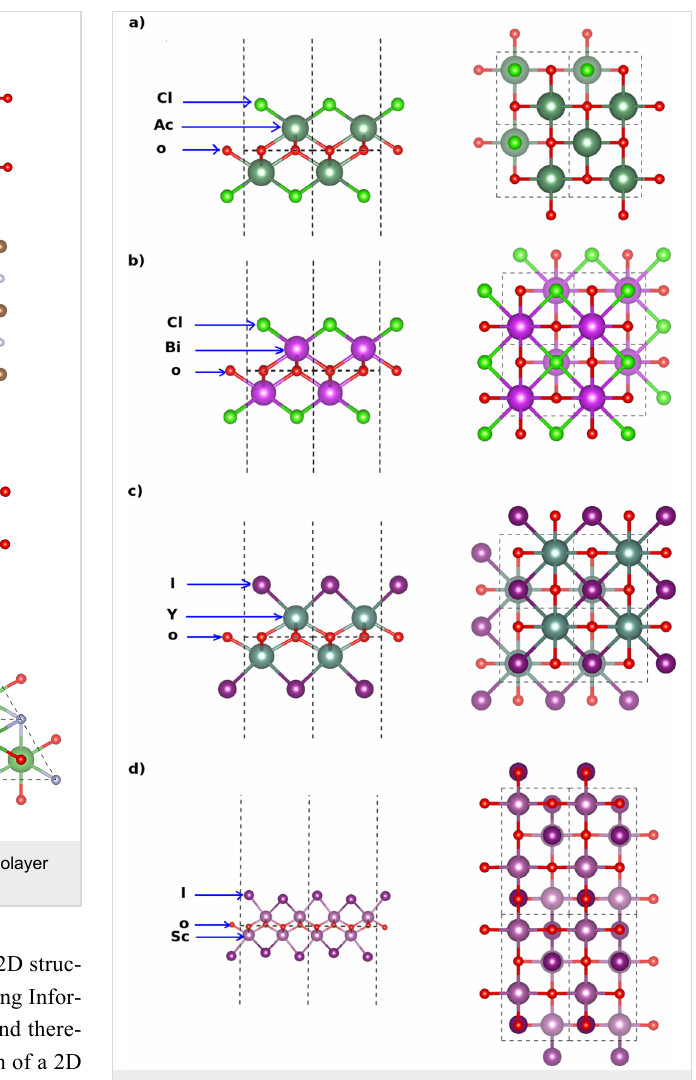
that the valence bands come from the Ac, O, and Cl atoms while the bottom of the conduction bands correspond mainly to states derived from the Ac atoms. The DOSs and PDOSs of the fluoride monolayers CrOF, GaOF, InOF and LaOF are shown in Figure 5. From the DOS, it can be seen that the CrOF mono- layer has a finite spin polarisation, and its magnetic moments are ordered ferromagnetically. Also, it is seen that the fluorine atoms contribute to the valence bands for all fluorides mono- layers, while the bottom of the conduction bands is a hybridi- zation between the Cr (La, Ga or In) and the O